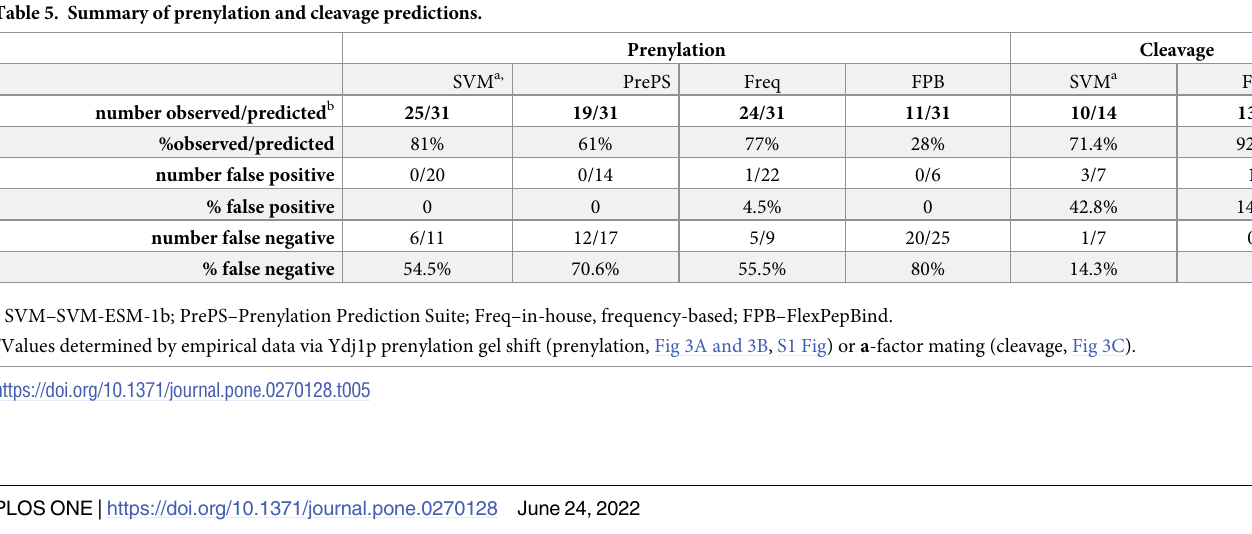
number observed/predicted a Signs represent predictions of prenylation and cleavage that were reported as positive (+) or negative (-) by the indicated model. b SVM–SVM-ESM-1b; PrePS–Prenylation Prediction Suite; Freq–in-house, frequency-based; FPB–FlexPepBind. c Observed by Ydj1p prenylation gel shift–see Fig 3B. d Observation previously reported [22].